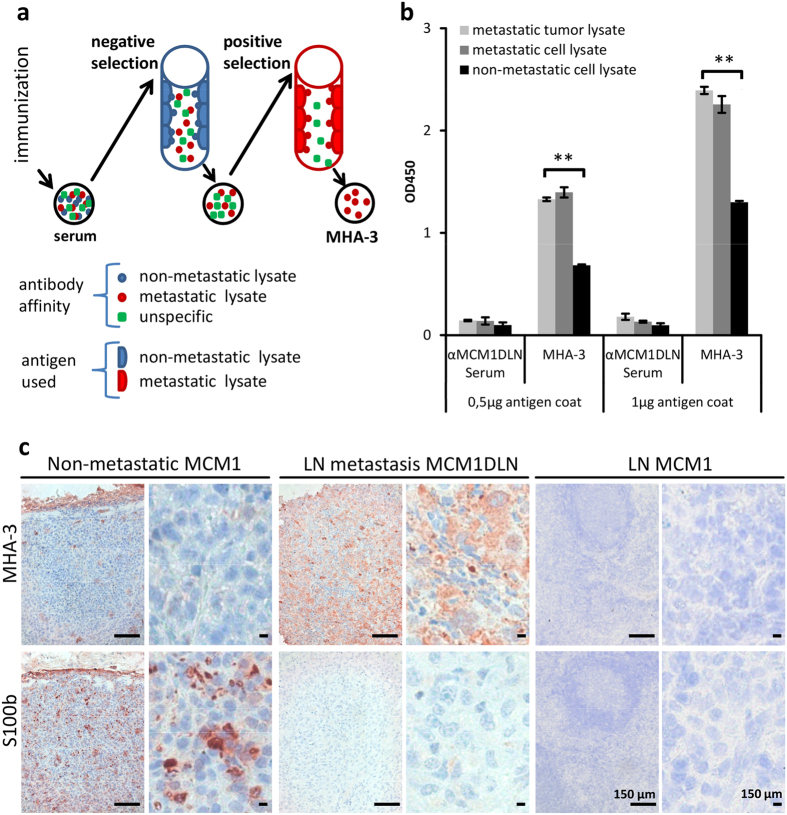
Affinity purification process.(a) Schematic representation of applied method. Serum after immunization contains antibodies against metastatic (red) and non-metastatic (blue) melanoma as well as non-specific antigens (green). Serum is first negatively selected by removing antibodies that bind to antigens from non-metastatic melanoma cells. Next, non-binding antibodies are positive selected by binding to metastatic melanoma antigens. The eluate is termed MHA-3. (b) ELISA coated with metastatic tumour and cell lysate and non-metastatic cell lysate at two different concentrations (0.5 and 1 μg/well). MCM1DLN serum and MHA-3 are used as primary antibodies. Experiments were done in triplicates and one-way Anova test was performed (**p < 0.01). Error bars represent standard error of mean. (c) Representative immunohistochemical images (from five tumour samples each) of MCM1 tumour (left), lymph node (LN) metastasis of MCM1DLN tumour (middle) and LN of MCM1 tumours (right) stained with S100b and MHA-3.